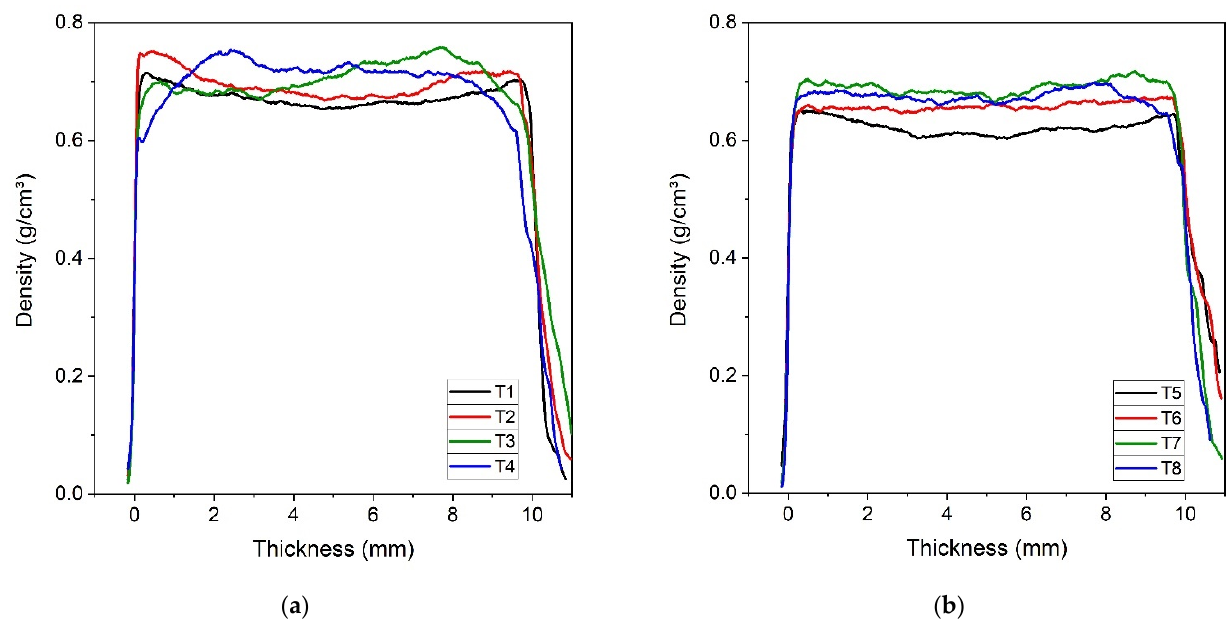
Figure 5. Density profiles obtained by X-ray densitometry. In ( a ) there are panels with 10% resin volumetric fraction and in ( b ) there are panels with 15% resin volumetric fraction.